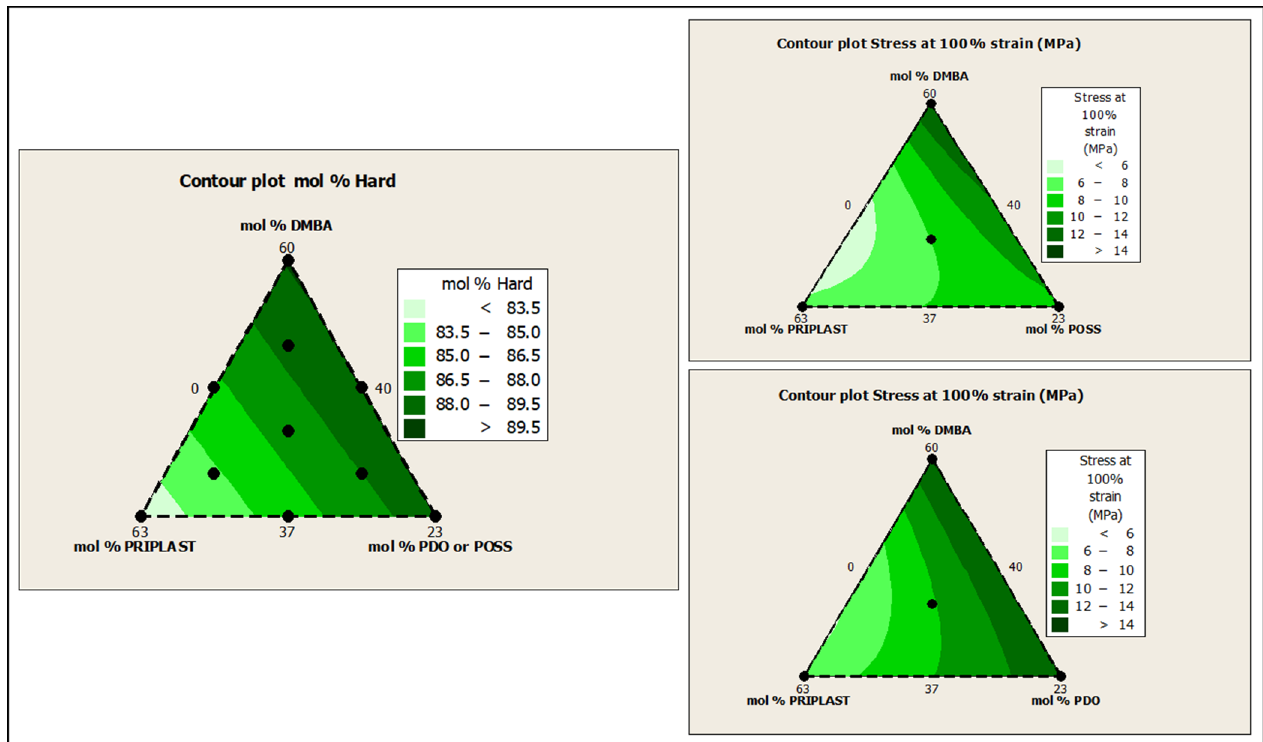
Figure 13. Contour plots obtained using the Minitab software from the ternary mixture experimental design. Left : contour plot of hard segment content in mol%. Upper right: contour plot of σ 100% (stress at 100% strain) for the ternary mixture design with POSS-OH. Bottom right: contour plot of σ 100% for the ternary mixture design with PDO.